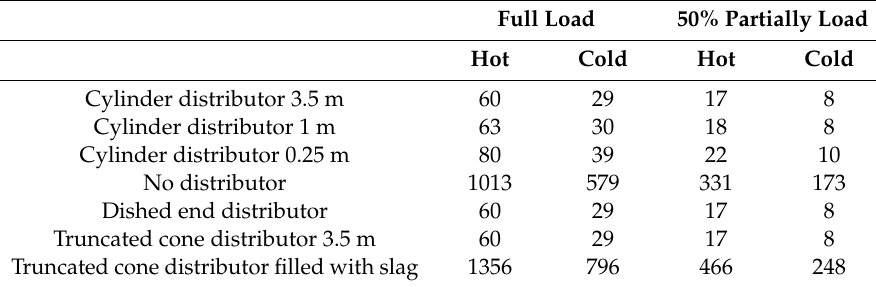
Table 7. Pressure drop over the storage (incl. distributor) in